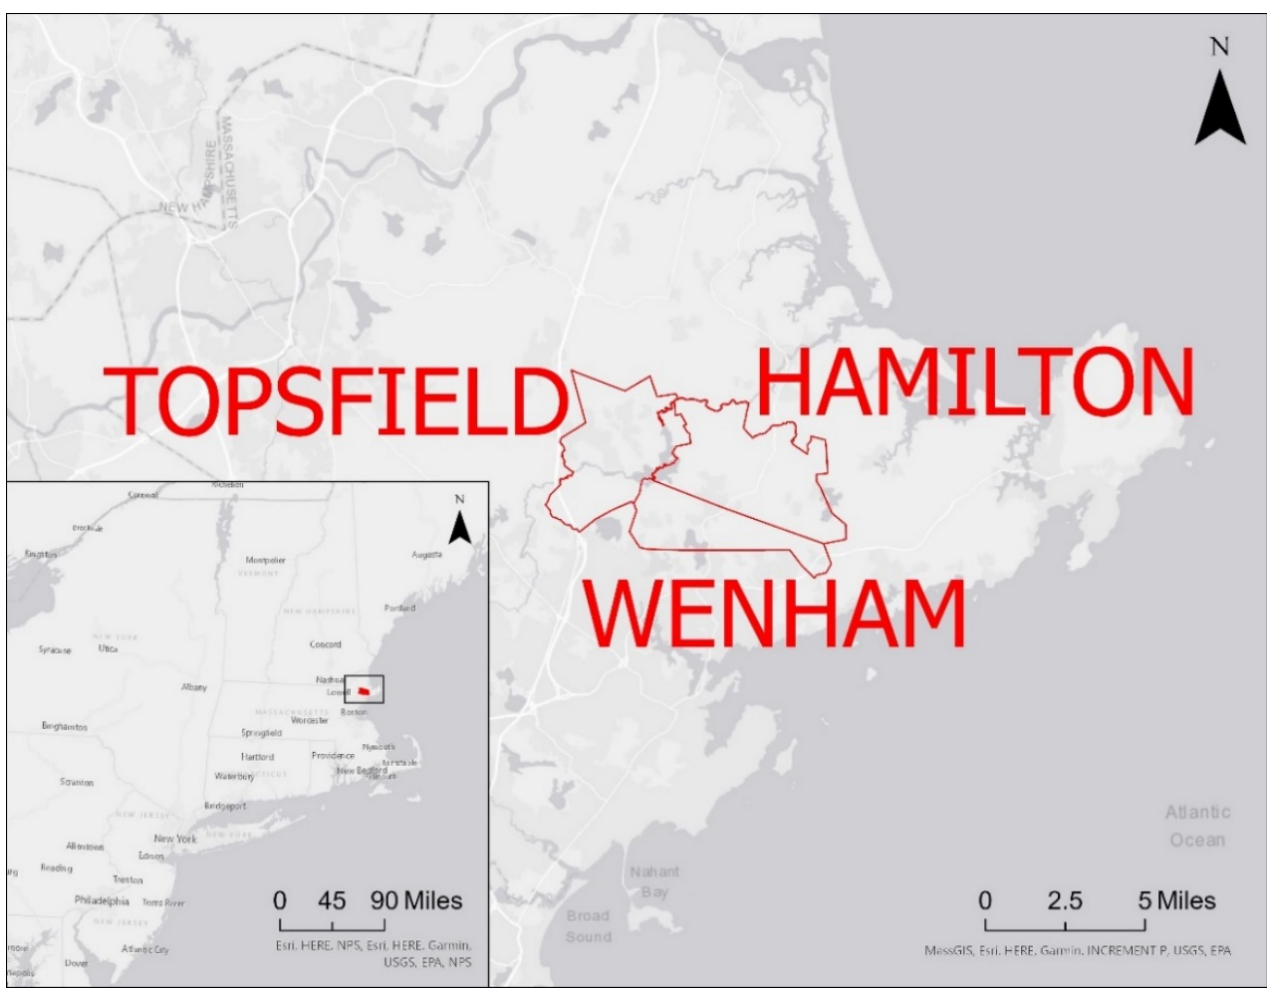
Figure 3. The Plum Island Ecosystems site consisting of the towns of Topsfield, Hamilton, and Wenham in northeastern Massachusetts, USA.